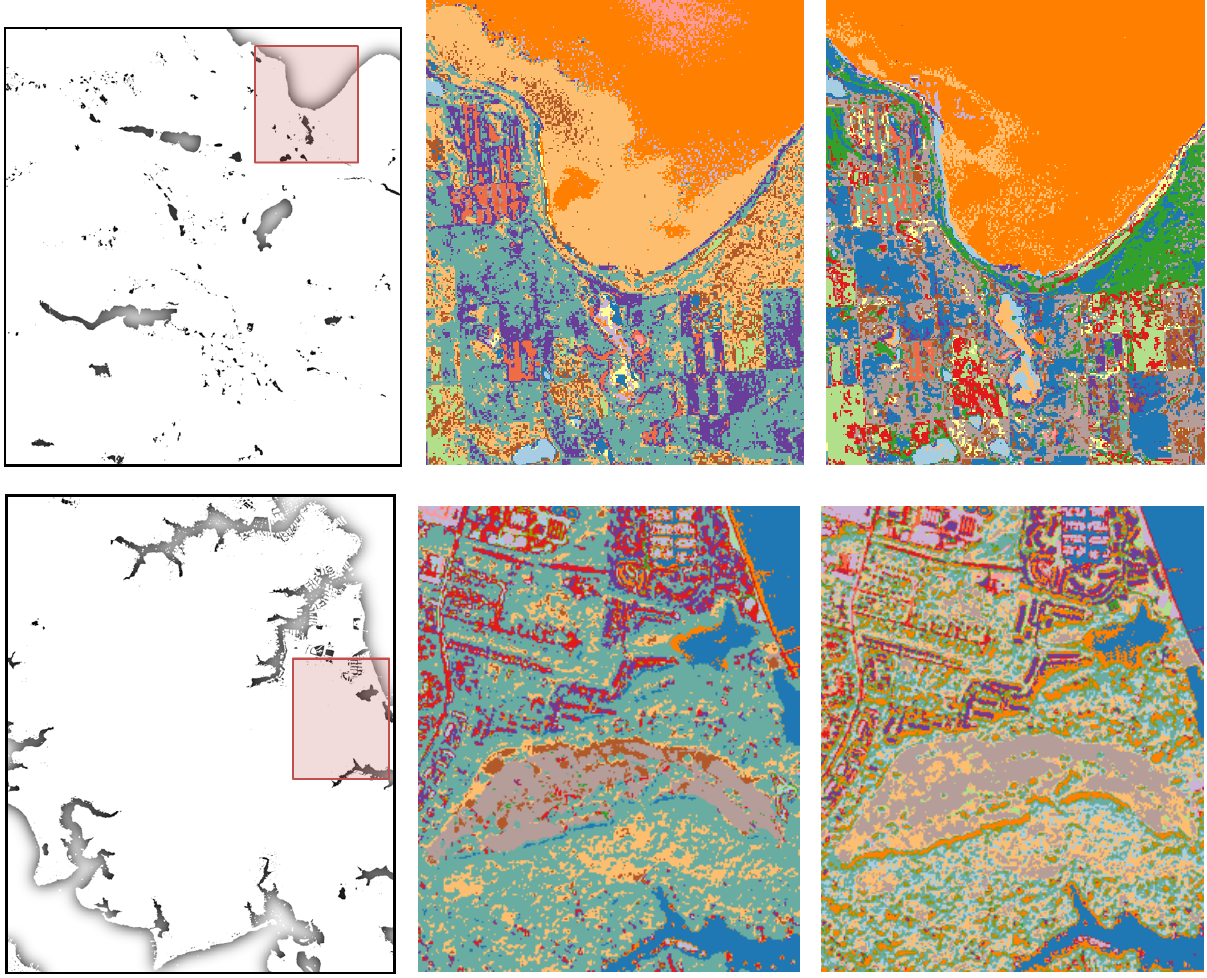
Figure 4. Upper row: Details of the upper right corner of the image CANADA2. Excerpt position ( left image), results for the original method ( middle image) and for the proposed method ( right image). Lower row: details of the golf course area of the image MARYLAND. Excerpt position ( left image), results for the original method ( middle image) and for the proposed method ( right image). Colors have no special